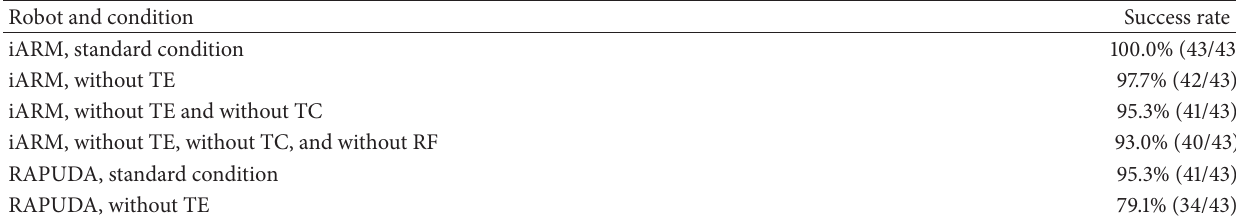
Table 1: Result of lifting experiment of robotic